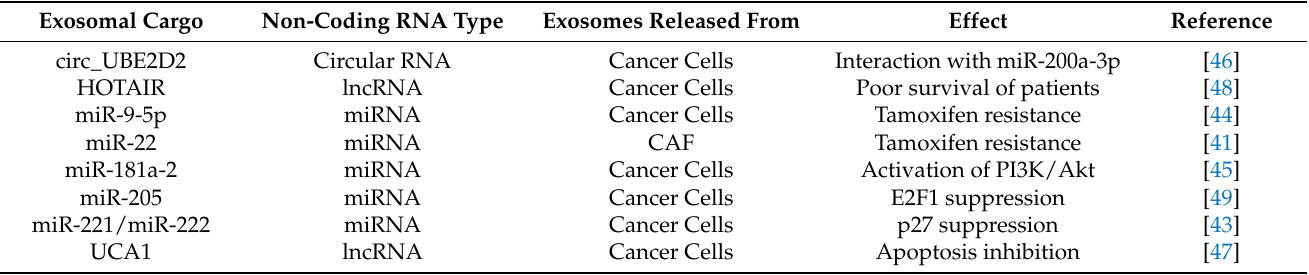
Table 1. Exosome-mediated tamoxifen